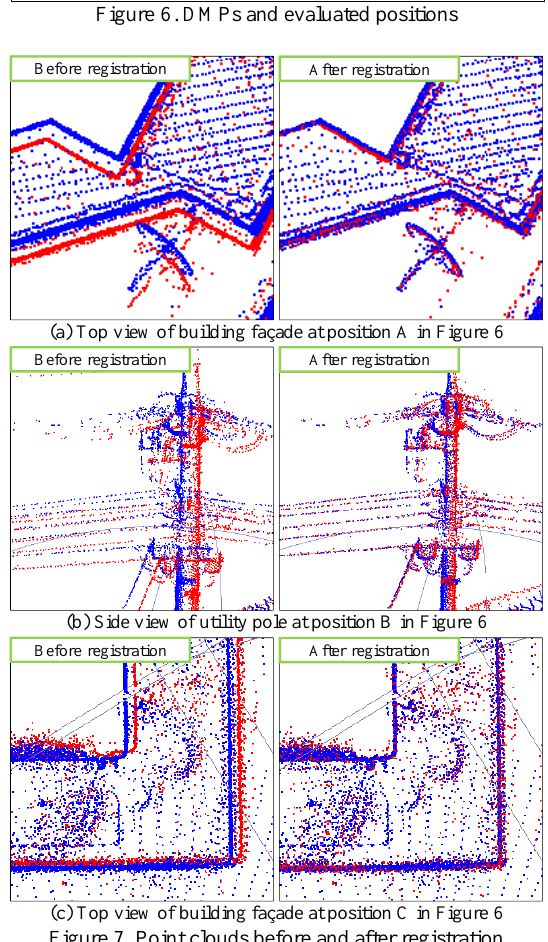
(c) Top view of building façade at position C in Figure 6 Figure 7. Point clouds before and after